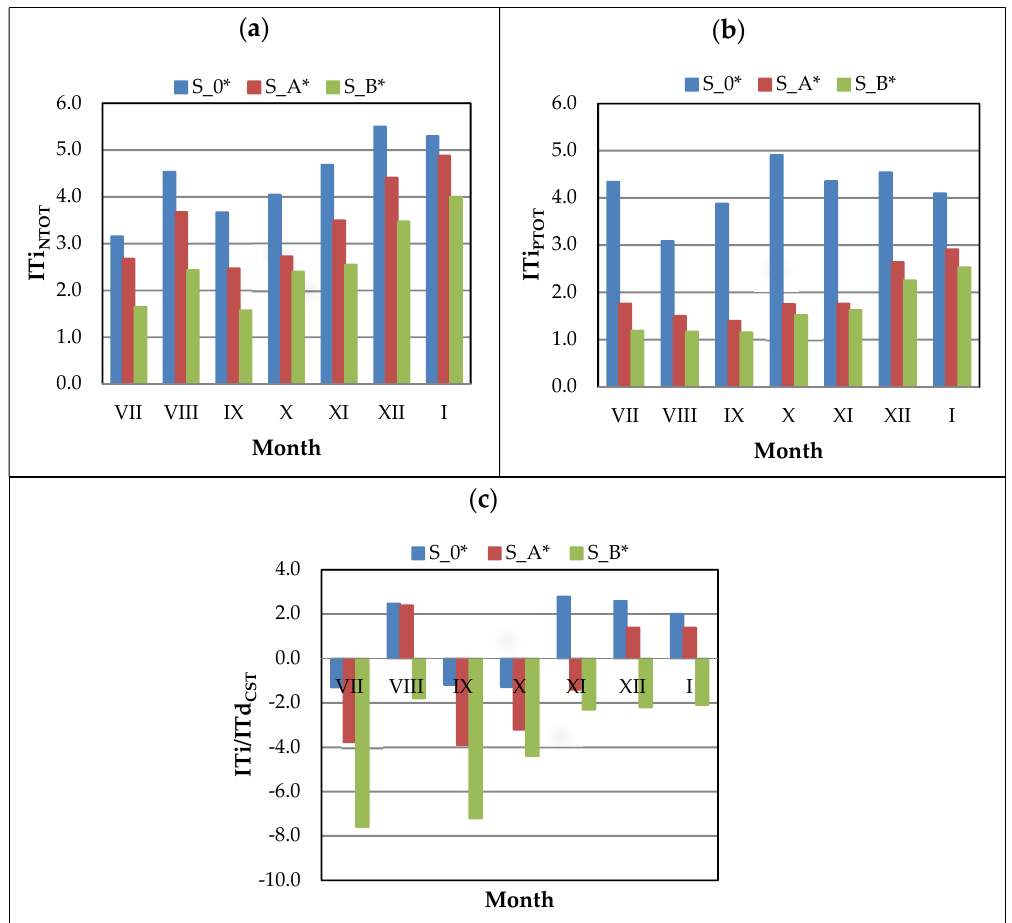
Figure A2. Values of indicators of the technological effects of WAS ultrasonic disintegration: ( a ) ITi NTOT ; ( b ) ITi PTOT ; ( c ) ITi/ITd CST . S_0*—sample after AD containing inoculum and original sludge; S_A*—sample after AD containing inoculum and WAS_A; S_B*—sample after AD containing inoculum and WAS_B.